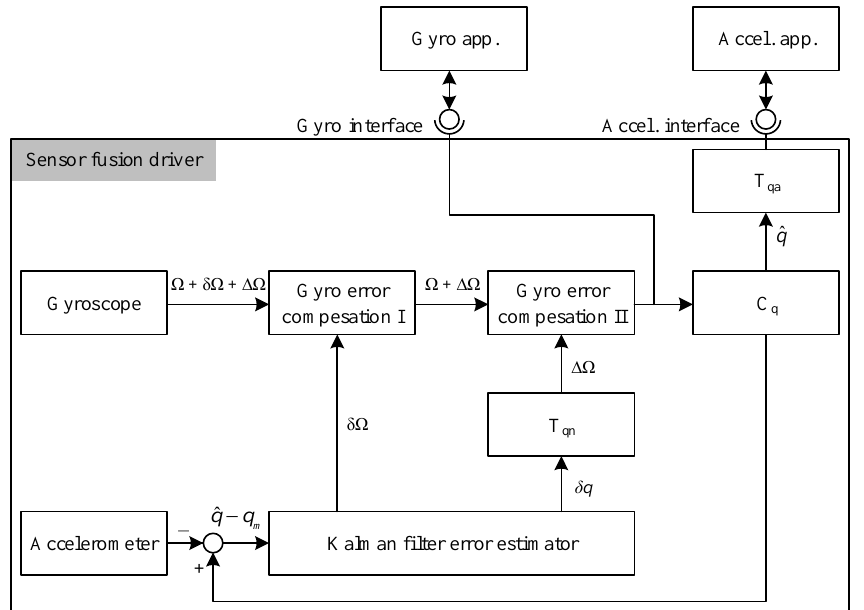
Figure 2. The proposed sensor fusion driver